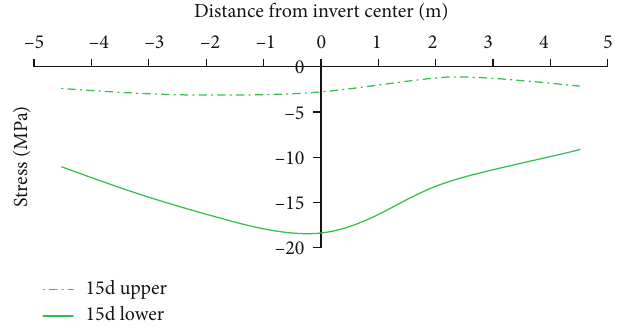
Figure 8: Stress on rebar on day